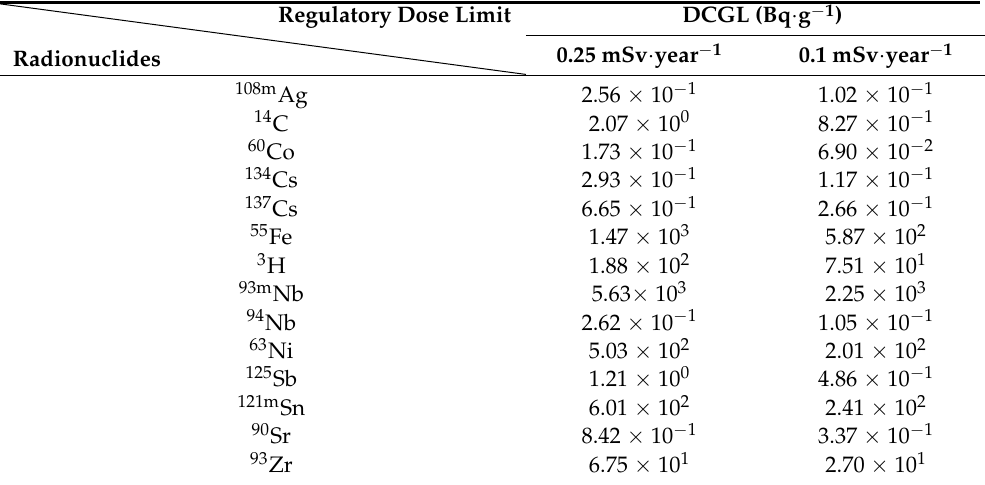
Table 4. DCGL results for various radionuclides were calculated with two different regulatory dose limits.